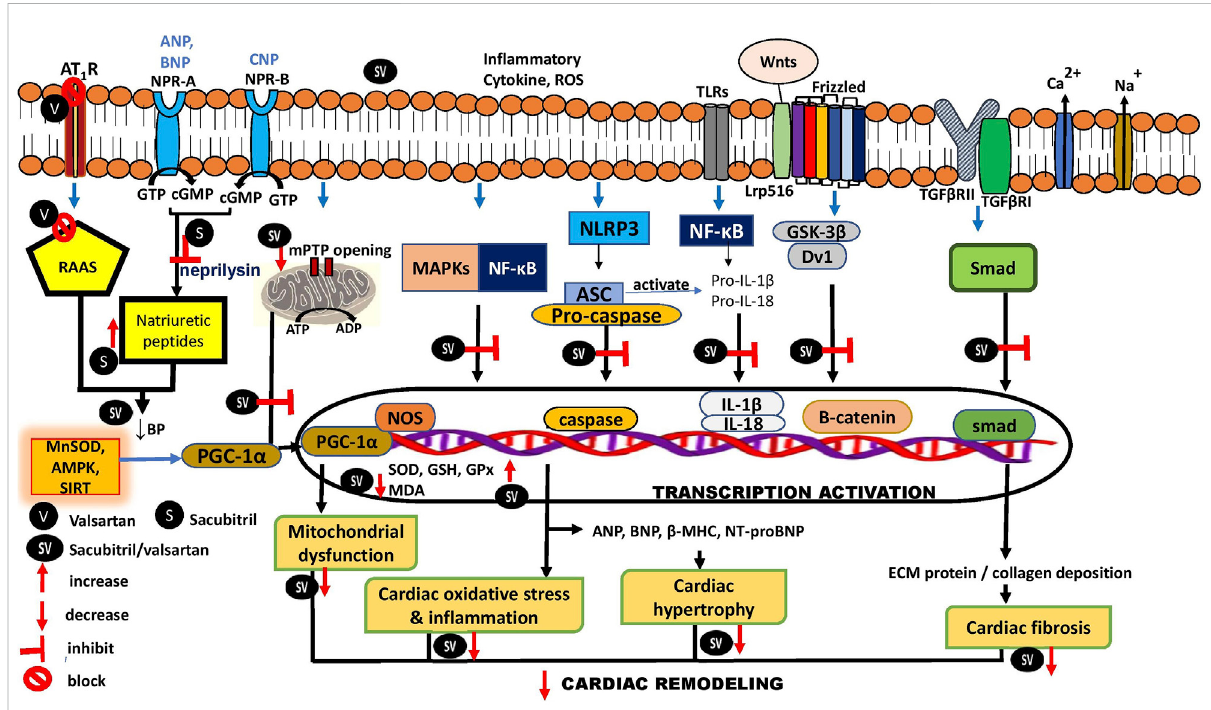
FIGURE 3 Schematic regulatory mechanisms for sacubitril/valsartan during cardiac remodeling. AMPK, AMP-activated protein kinase; ANP, atrial natriuretic peptide; ASC, apoptosis-associated speck-like protein containing a caspase; ATP, adenosine triphosphate; BNP, B-type natriuretic peptide; BP, blood pressure; cGMP, cyclic guanosine monophosphate; CNP, C-type natriuretic peptide; CTGF, connective tissue growth factor; Drp1,Dynamin-relatedproteinone;Dv1,signaltransductionmoleculedisheveled;ECM,extracellularmatrix;ERK,extracellularsignal-regulated kinase;GPx,glutathioneperoxidase;GSH,glutathione;GTP,guanosinetriphosphate;IL,interleukin;JNK,c-JunN-terminalkinases;MAPK,mitogen- activated protein kinase; MDA, malondialdehyde; MFN2, Mitofusin-2; β -MHC, β -myosin heavy chain; MMPs, matrix metalloproteinases; MnSOD, manganese suoeroxide dismutase; mPTP, mitochondrial permeability transition pore; NF- κ B, nulear factor- κ B; NLRP3, NOD-like receptor protein three; NOS, nitric oxide synthases; NPR-A, natriuretic peptide receptor A; NPR-B, natriuretic peptide receptor B; PGC-1 α , peroxisome proliferator- activated-receptor-1 α ; NT-proBNP, N-terminal pro-BNP; RAAS, renin-angiotensin-aldosterone system; SIRT, mitochondria sirtuin; TGF- β R, transforming growth factor β receptor, TLRs, Toll-like